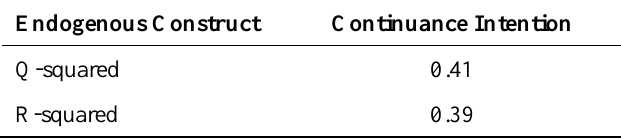
Table 5: R 2 and Q 2 Coefficients